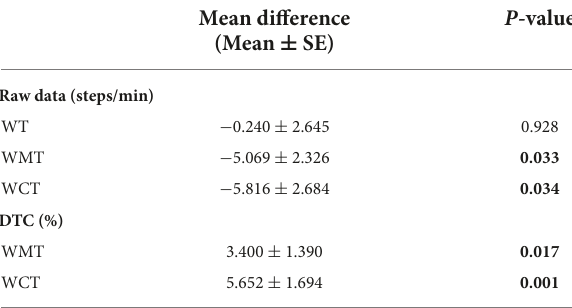
TABLE 7 Paired comparison of fqCADENCE parameters (raw date and DTC) between MCI group and NE